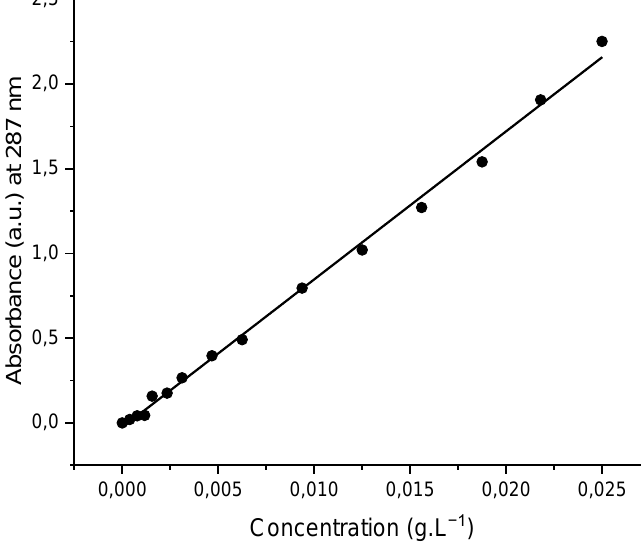
Figure 2. Calibration curve of OFL recorded in deionized water.